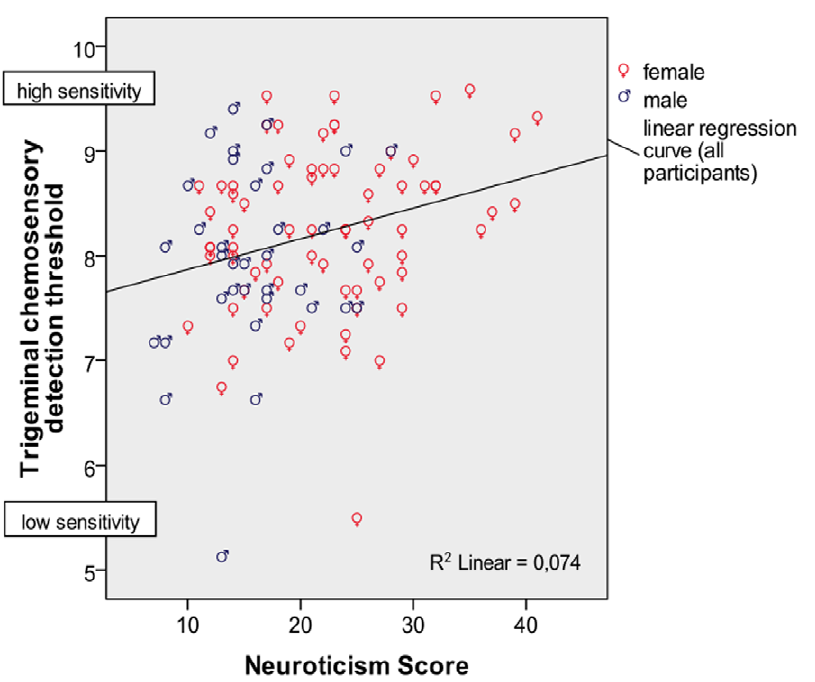
Figure 2. Trigeminal chemosensory detection threshold and neuroticism scores in male and female participants.